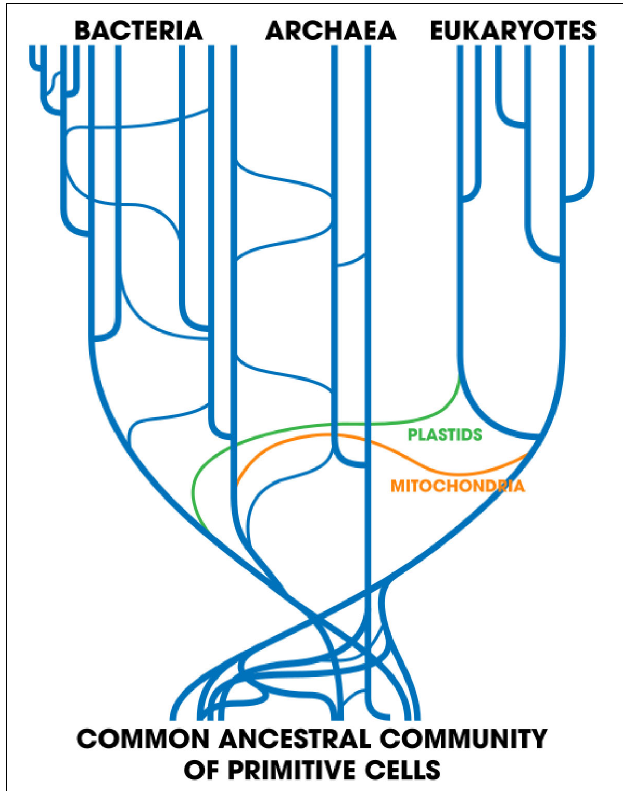
FIGURE 3 | Taken from Smets and Barkay (2005). Horizontal gene transfer: Perspectives at a crossroads of scientific disciplines. Created: 23 May 2018; License: CC-BY-SA